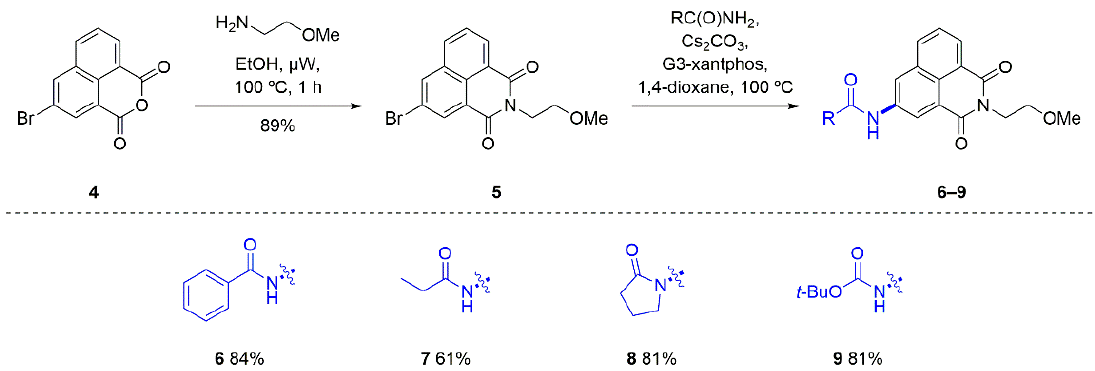
Cells 2021 , 10 , x 3 of 11 Figure 2. Top: All published examples of 3-substituted scriptaid analogues [38–40], and Bottom: selected examples of 4-substituted scriptaid analogues from our recent work [41]. No activity data for 1 and 2 has been published. Selectivity factor (SF) = HDAC1 IC 50 /HDAC6 IC 50 . Herein we outline the methodology for the direct synthesis of 3-amido-1,8-naph- thalimides and the use of this approach to construct a set of scriptaid analogues. The re- sults of the photophysical and biological assessment (IC 50 and in cell tubulin acetylation) are also presented. 2. Results and Discussion 2.1. Methodology To trial the Buchwald–Hartwig amidation methodology, 3-bromo-1,8-naphthalimide 4 was first required. The treatment of 1,8-naphthalic anhydride with 1.1 equiv. N -bromo- succinimide in H 2 SO 4 provided the desired brominated compound 4 in >90% purity after trituration with EtOH [44]. The bromoanhydride was then converted to the corresponding methoxyethyl imide 5 using microwave irradiation (Scheme 1, see supplementary